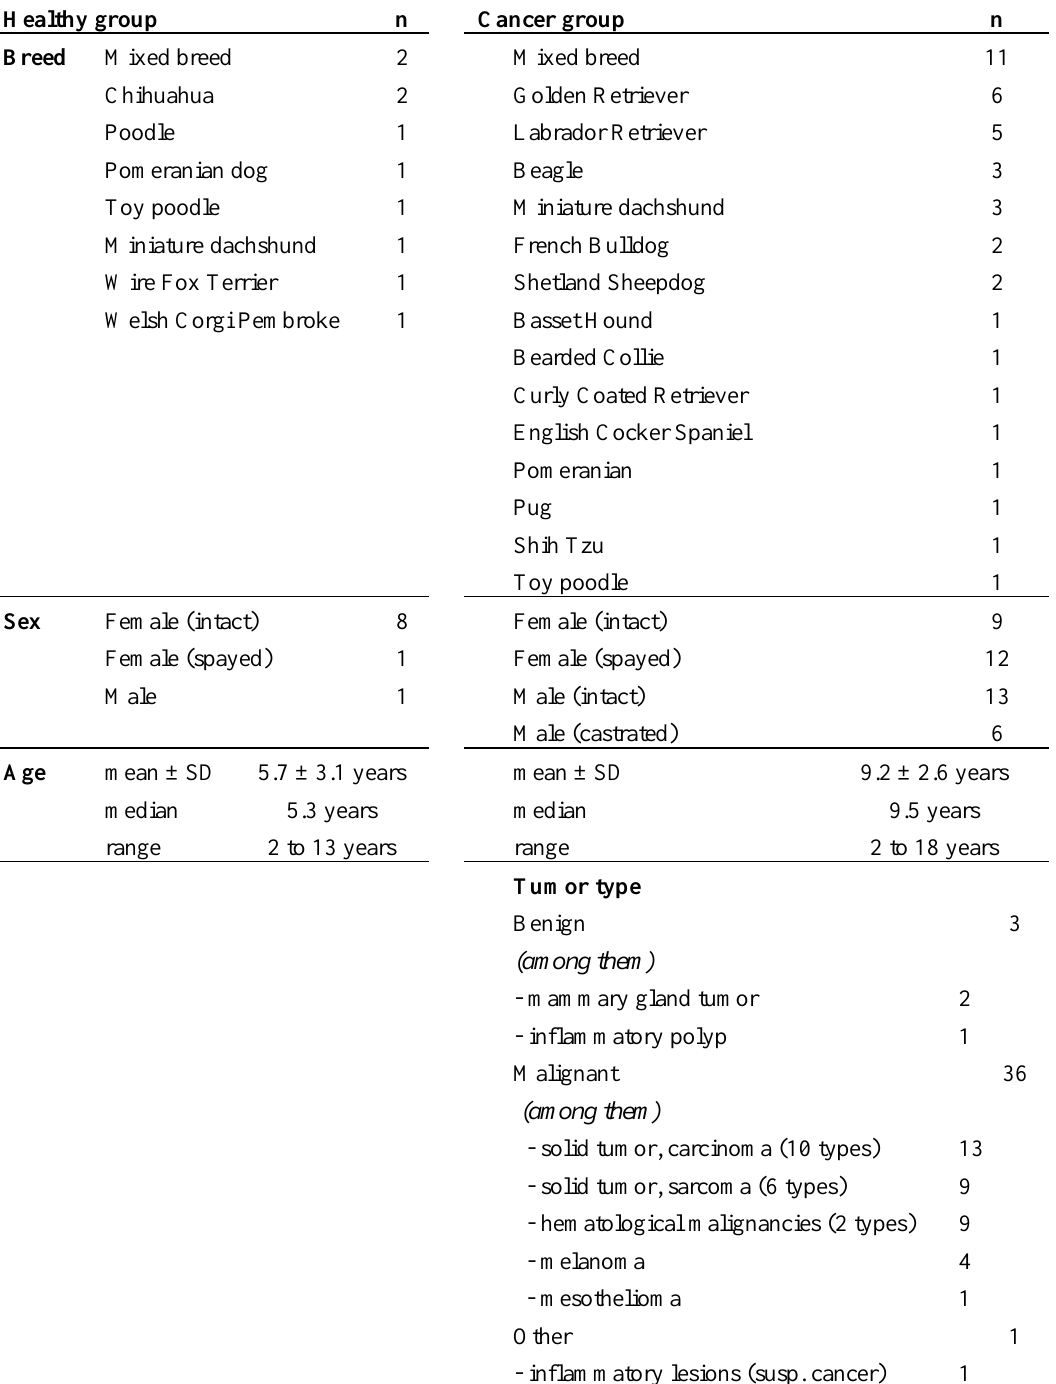
Table 1. Samples description data: number, breed, age, sexual status, type of